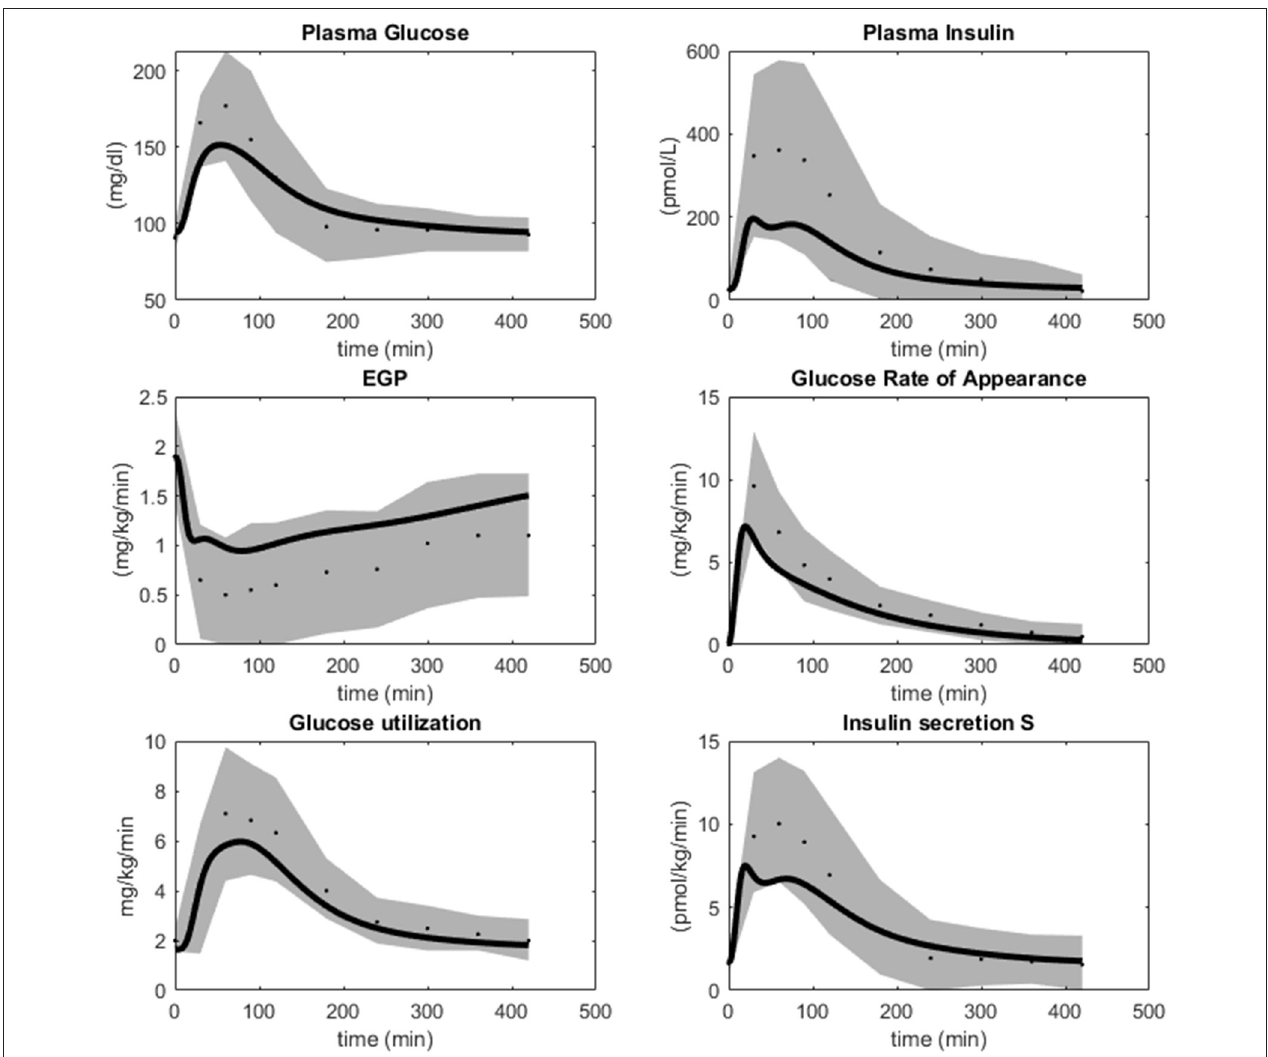
FIGURE 6 | Simulations of M4 (lines) in comparison with data (dots) and uncertainties (gray areas) from Dalla Man et al. (2007). M4 simulations are within the data uncertainties established in Dalla Man et al. (2007).